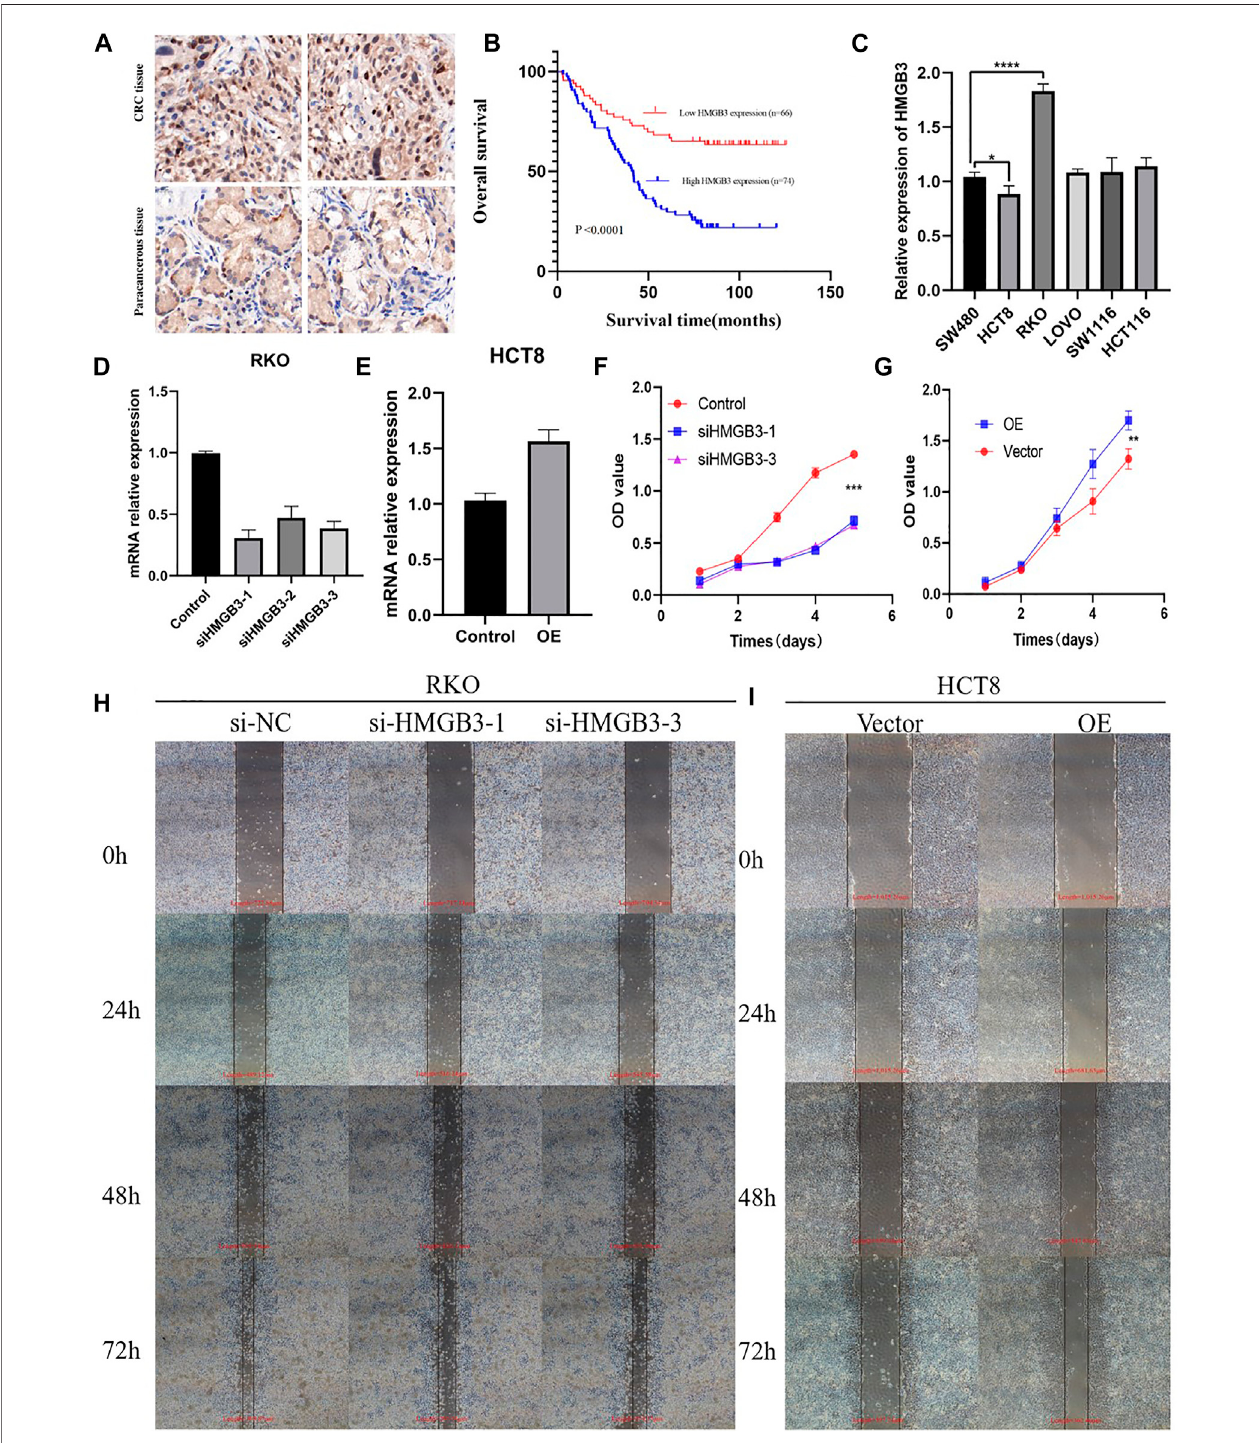
FIGURE 7 | (A) CRC tissue and paracancerous tissue samples from TMA were tested by IHC. (B) Kaplan-Meier curves with univariate analyses (log-rank) for patients with low HMGB3 expression (red line) versus high HMGB3 expressing tumors (blue line). (C) Expression of HMGB3 in colorectal cancer cell lines. There experiments were repeated for three times. (D,E) Silencing and overexpression of HMGB3 in colorectal cancer cell lines and detection of HMGB3 expression by qPCR. There experimentswererepeatedforthreetimes. (F,G) SilencingandoverexpressionofHMGB3inacolorectal cancercellline,CCK-8 assayforcellviability.There experimentswererepeatedforthreetimes. (H,I) SilencingofHMGB3andoverexpressionofHMGB3incolorectalcancercelllines,woundhealingassaysforcellmotility. There experiments were repeated for three times.